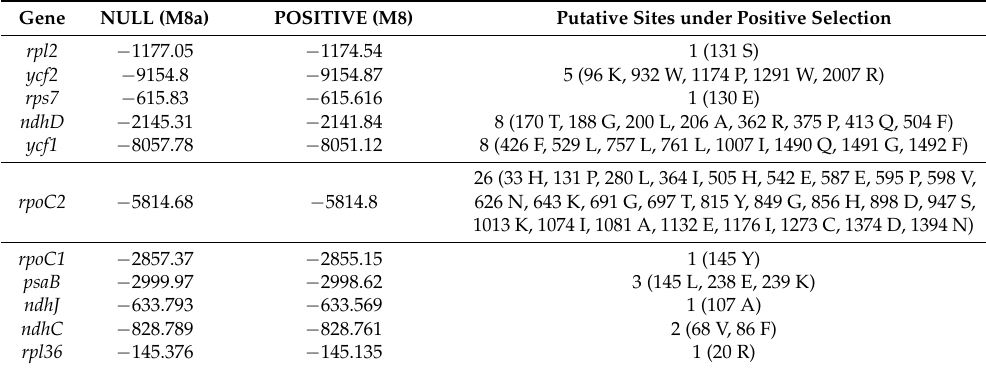
Table 2. Positive selection sites identified by Selecton.